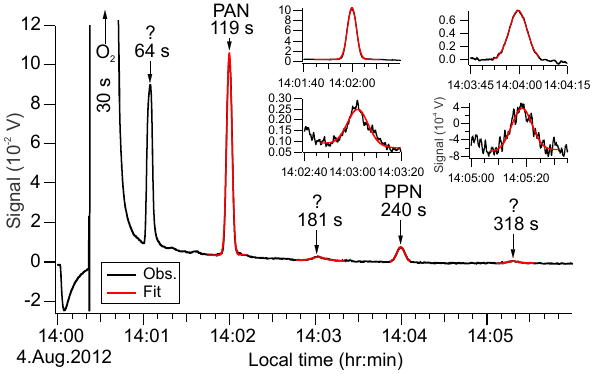
Figure 9. Chromatogram of ambient air acquired in Abbotsford on 21 July 2012, 02:36 local time with the PAN-GC operated in “CAP” setting mode. Other conditions were the same as in Fig. 8. The peak area corresponds to a PAN mixing ratio of (8 . 1 ± 0 . 4)pptv. Retention times are greater than in Fig. 8 due to a lower column temperature. Table 8. Response factors of the TD-CIMS for PAN, PPN, MPAN and APAN determined in the laboratory. Uncorrected response fac- tors (RF u ) , response factors corrected for sample impurities, when quantifiable (RF cor ) , zero offsets ( b ), the r value of the calibration plot, and response factors relative to PAN. TD-CIMS counts were normalized to 1 × 10 6 reagent ion counts at m/z 127.